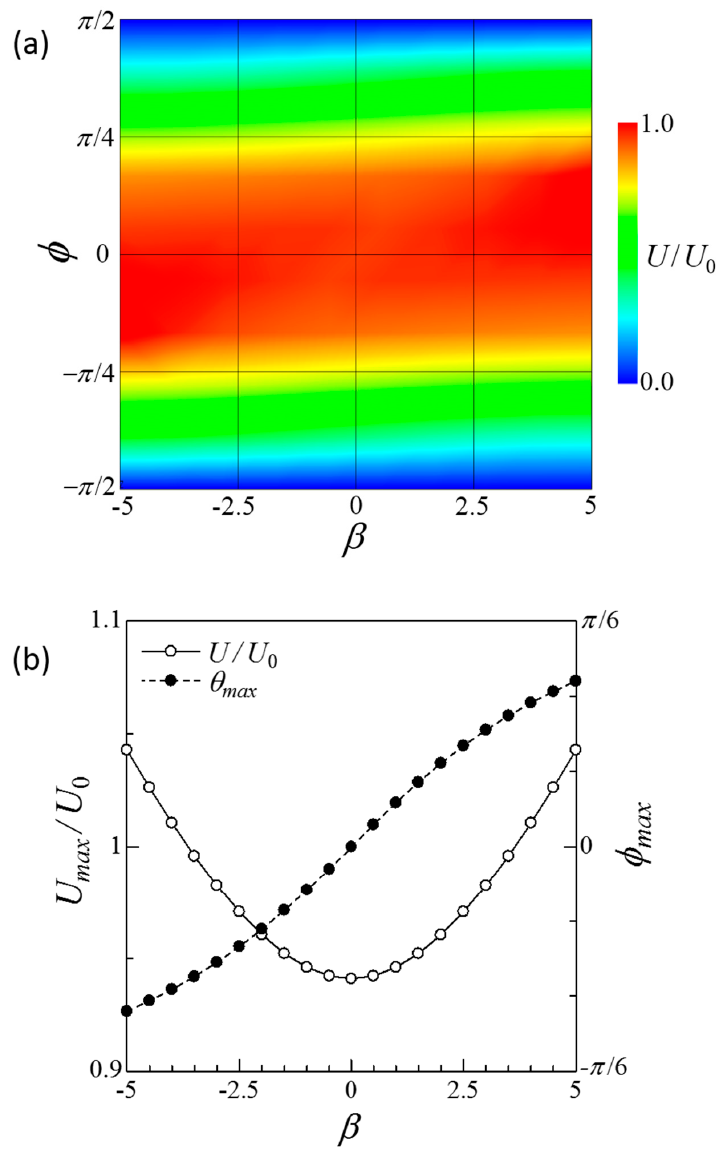
Figure 3. Swimming velocity of a side-by-side dumbbell squirmer connected by a short rigid rod. ( a ) Contour plot of the velocity in β – φ space. ( b ) Maximum velocity U max and the angle with maximum velocity φ max at each β value.